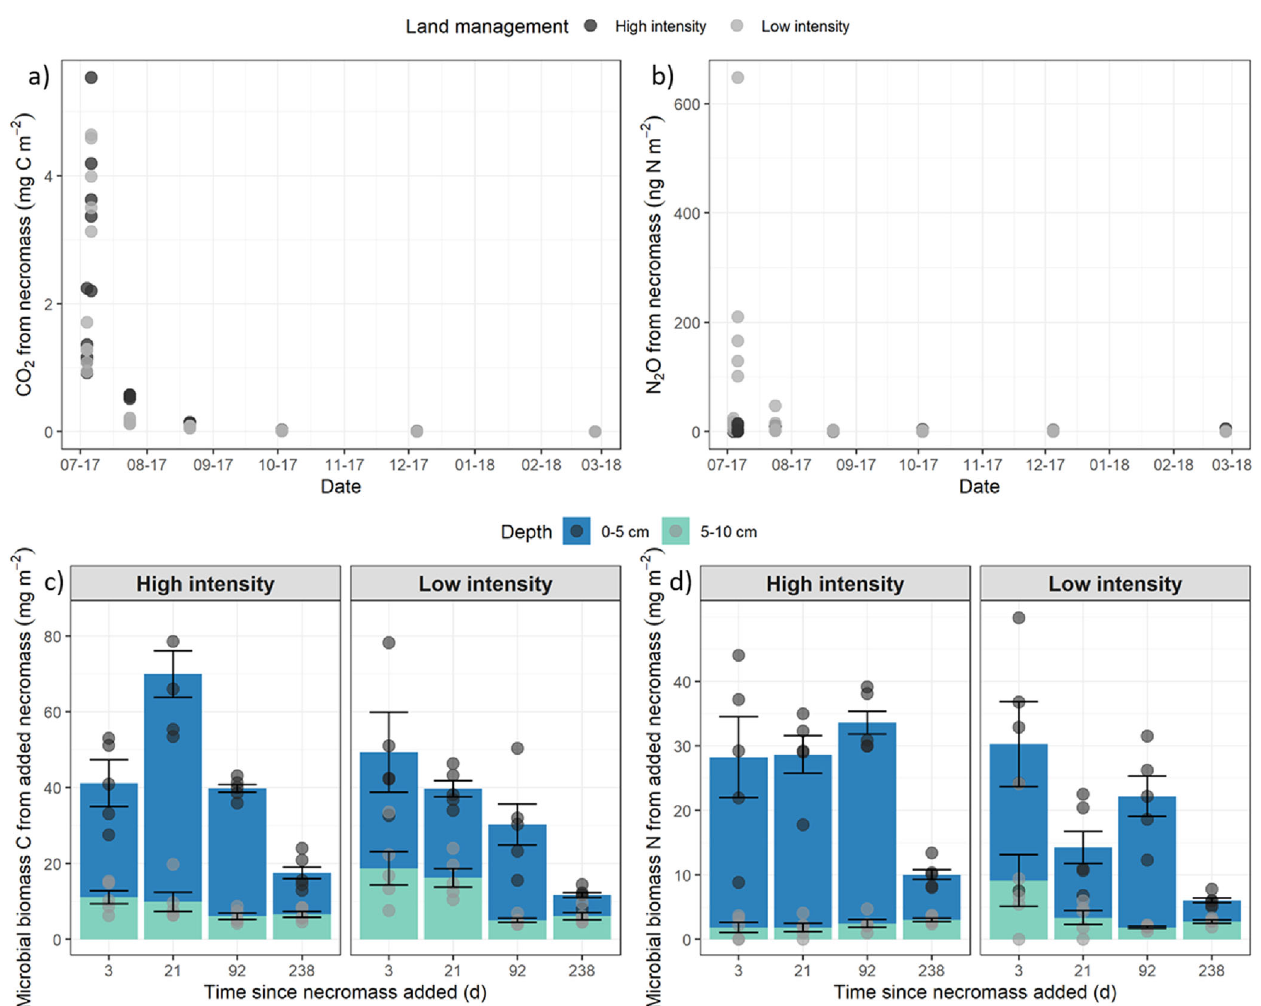
Fig. 3 Less than half of the fi eld-added necromass carbon was mineralised or consumed by microbes. Mean (and standard error, n = 5) carbon and nitrogen from the added necromass released as CO 2 -C ( a ), and N 2 O-N ( b ), and recovered in the microbial biomass C ( c ), and the microbial biomass N ( d ), in high- and low-intensity pastures soils at two soil depths (0 – 5 and 5 – 10 cm). 13 C 15 N-labelled E. coli necromass (2.14 g C and 0.62 g N m − 2 ) was injected on 3/07/17, 1 day before the fi rst gas sample